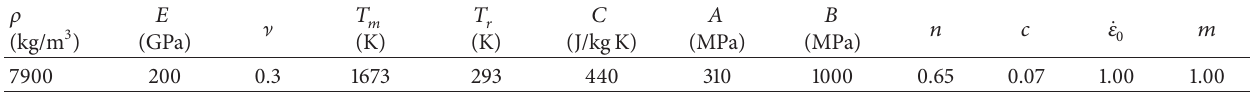
Table 3: Material properties and Johnson-Cook parameters for the annealed 304 stainless steel [18].